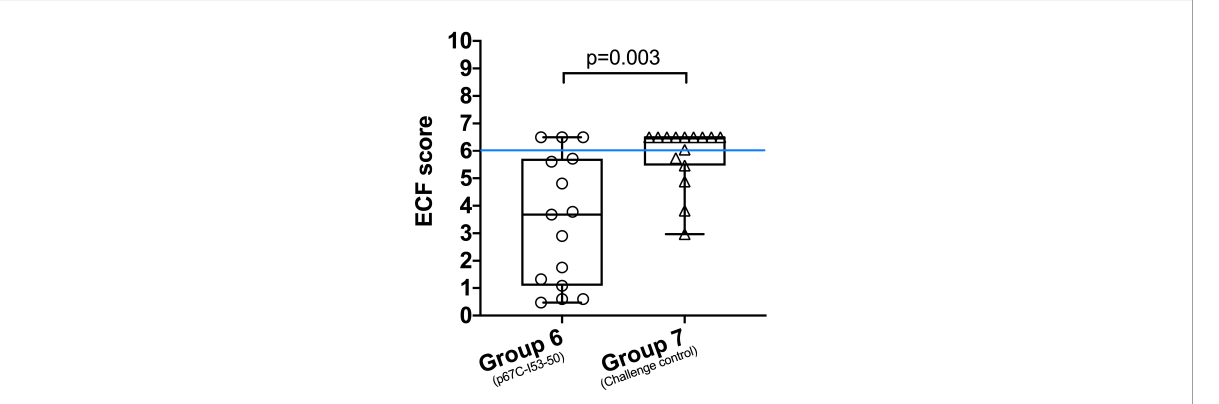
FIGURE 9 ECF scores of animals in group 6 (p67C-I53-50) and group 7 (challenge control). The median and the 25 th and 75 th percentile are shown as a box and the min and max values are shown with black bars. Individual animals are also presented (n=15). A blue line separates the protected and